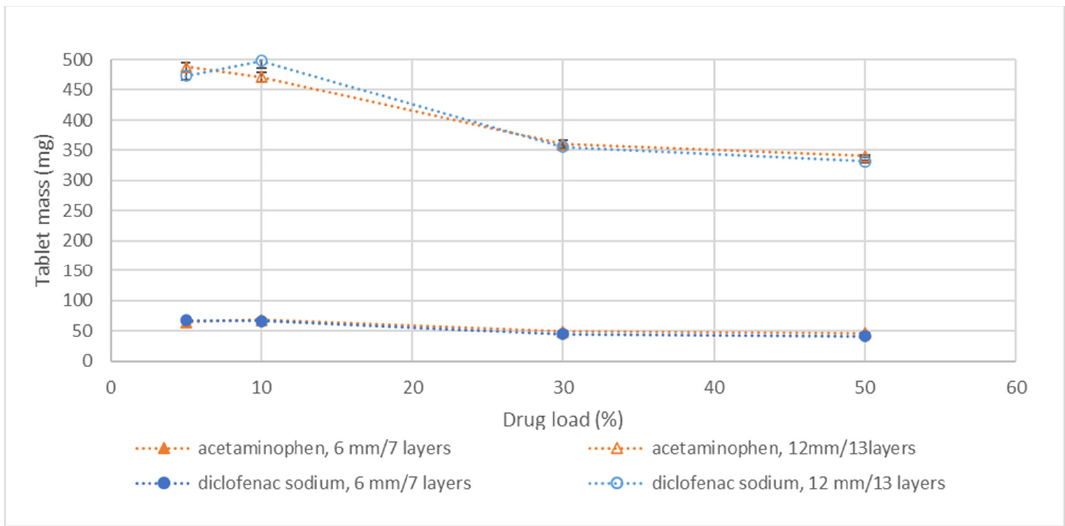
Figure 3. Tablet mass versus drug load for both acetaminophen and diclofenac sodium formulations. The tablets were printed according to the formulations and print settings as provided in Table 4, meaning that the 50% w / w acetaminophen formulation contains 0.5% w / w silica and the 30 and 50% w / w diclofenac sodium formulation contains coarse API and were printed without outer line. Please note that standard deviations for all data points are presented but not visible for the 6 mm/7- layer tablets. In this case, all values of standard deviation were <2.5 mg. The complete dataset of all drug loads can be found in the supplementary information Figure S1.